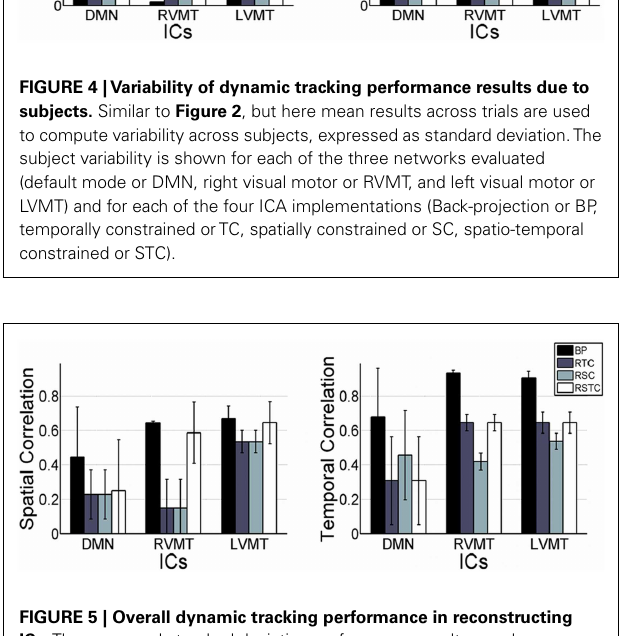
FIGURE 5 | Overall dynamic tracking performance in reconstructing ICs. The mean and standard deviation performance results are shown across subjects and trials in terms of both spatial and temporal correlation with the template ICs.The results are shown for each of the three networks evaluated (default mode or DMN, right visual motor or RVMT, and left visual motor or LVMT) and for each of the four ICA implementations (Back-projection or BP, temporally constrained or RTC, spatially constrained or RSC, and spatio-temporal constrained or RSTC).